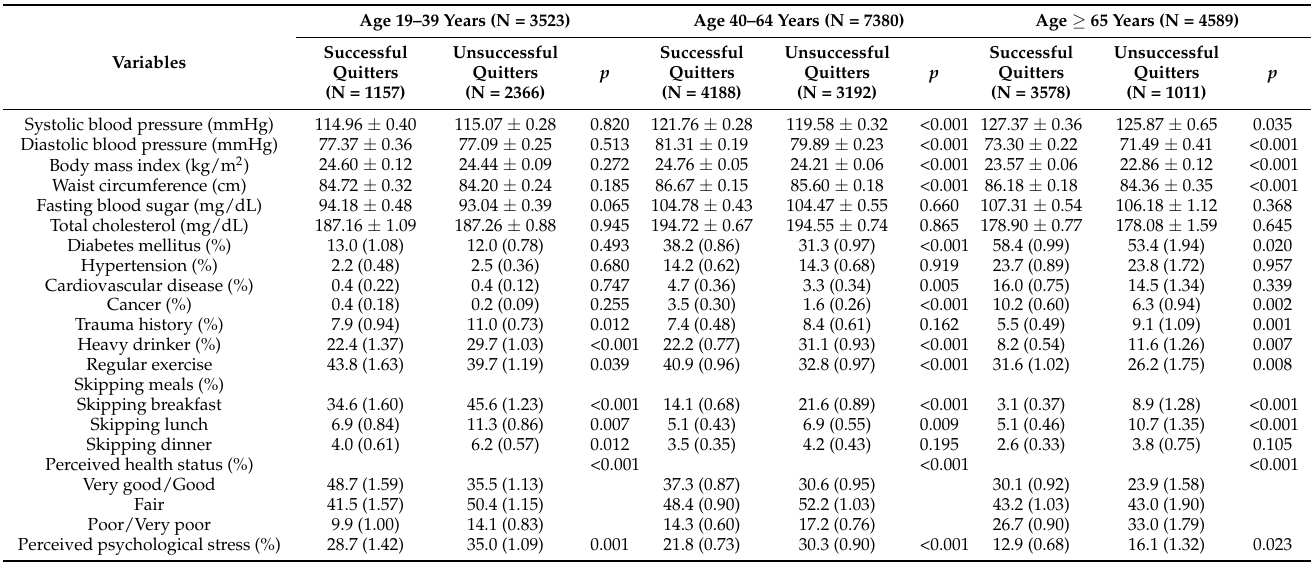
Table 3. Clinical characteristics, health behaviors, and perceived health status of study participants by age group (N = 15,492).